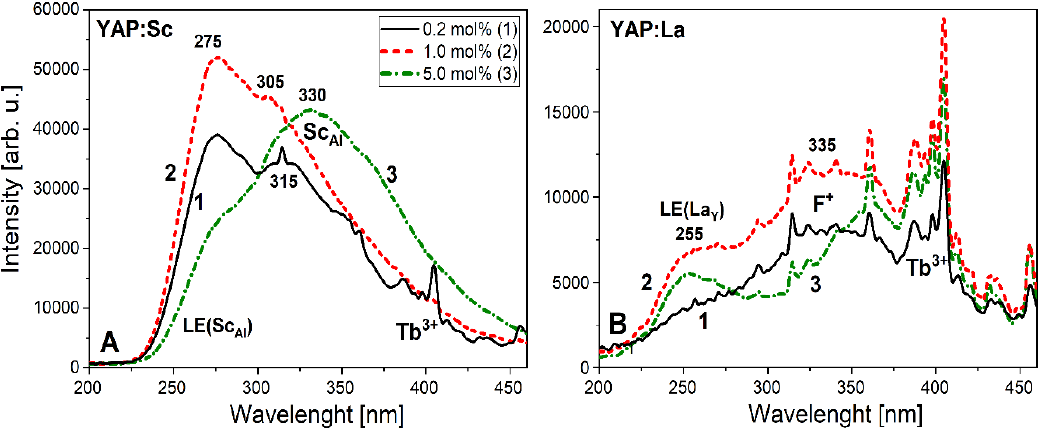
Figure 2. The cathodoluminescence (CL) spectra of YAlO 3 :Sc ( A ) and YAlO 3 :La ( B ) crystals with different Sc 3+ and La 3+ dopant concentrations measured at room temperature.